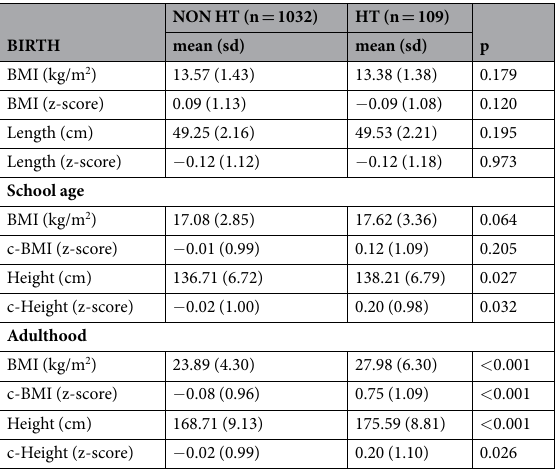
Table 4. Anthropometric variables at birth, school age and adulthood in a population–based birth cohort born in 1978–79 in Ribeirao Preto, Brazil, by hypertension status in adulthood. HT = hypertension; BMI = body mass index; c-BMI = conditional BMI; c-height = conditional height; statistic test: t-test.